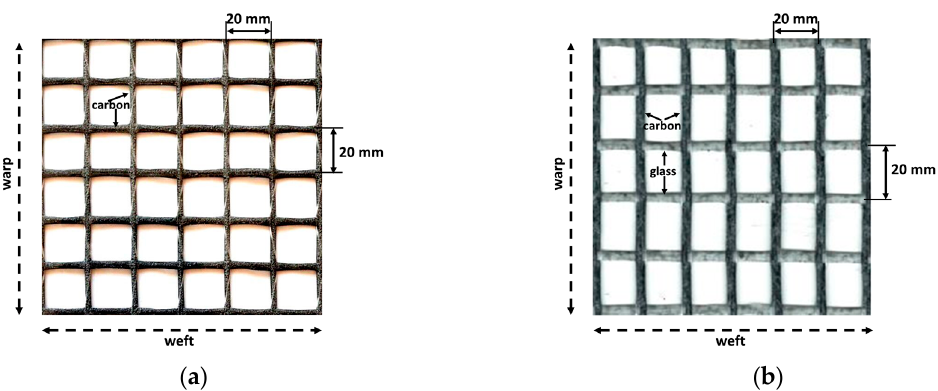
Figure 1. Fabrics used in the production of FRCM composites: ( a ) C fabric; ( b ) CL fabric.